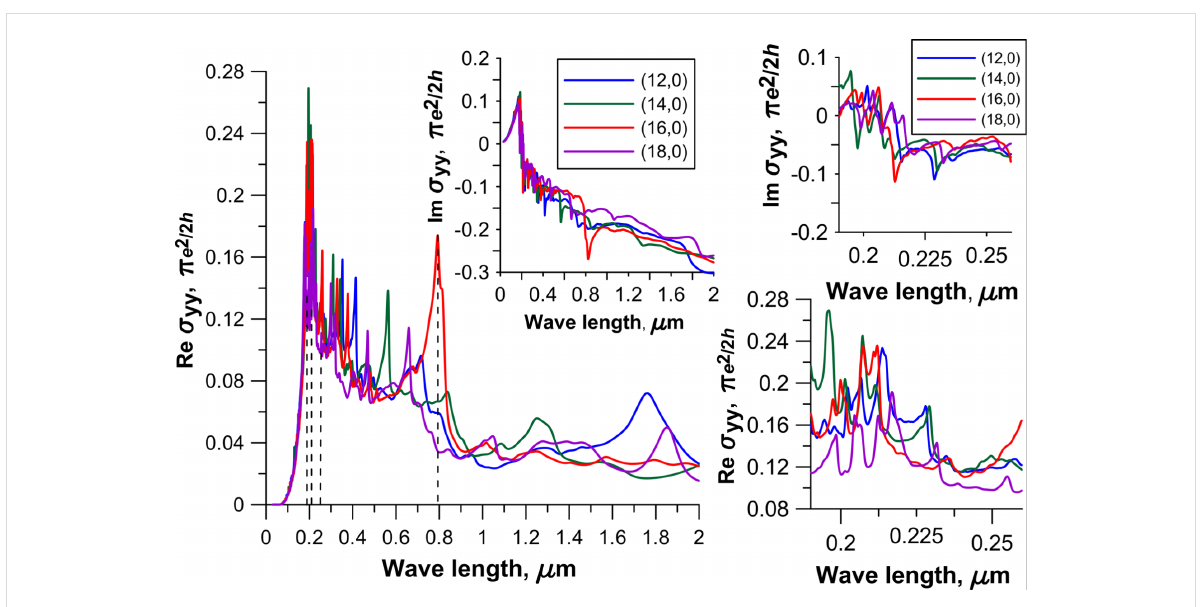
Figure 4: The optical conductivity of 2D CNT–graphene hybrid nanocomposites with an intertube distance of 13 hexagons along the nanotube axis. The insets on the right side show the graphs of optical conductivity for the wavelength range of 190–260 nm.